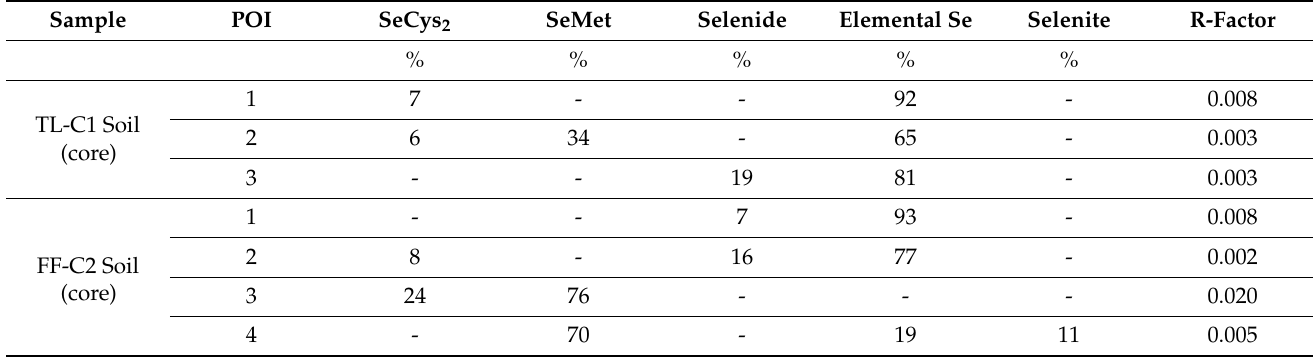
Table 6. Linear combination fits for selected selenium non ‐ accumulator species measured in ATHENA. The goodness of fit is determined by the R ‐ factor. The improvement in the fit for values <4% is marginal.